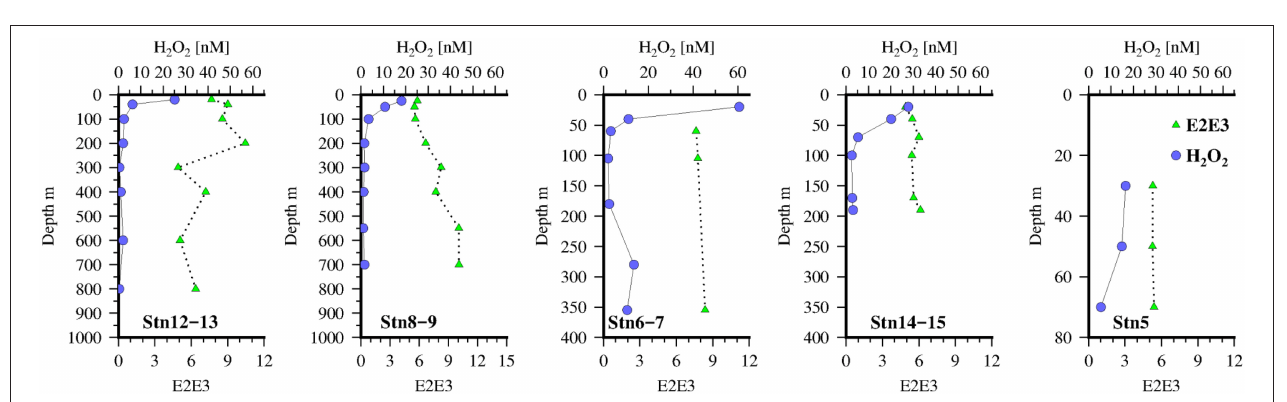
FIGURE 4 | Vertical distribution of H 2 O 2 (blue circles) and E 2 :E 3 (green triangles) at the 5 Go-Flo stations along the transect in the Mauritanian